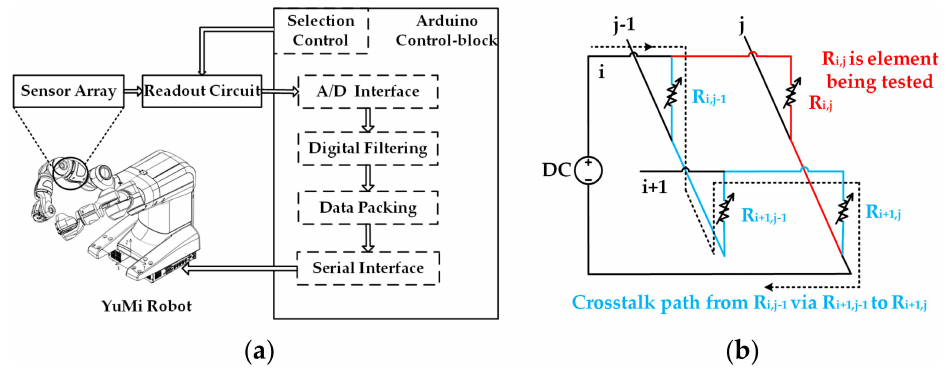
Figure 5. The schematic of the tactile sensing system: ( a ) Real-time sensing system for YuMi Robot;